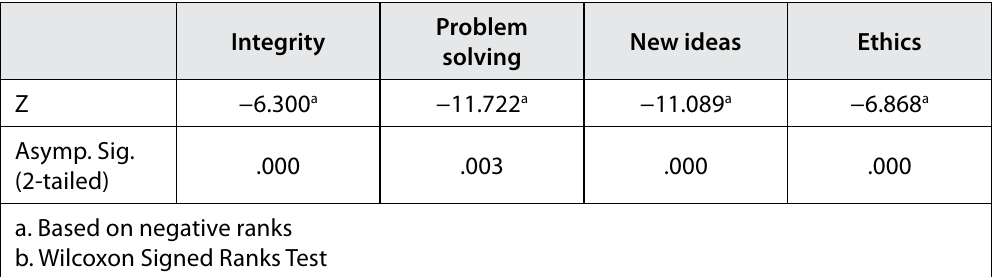
Table 8 Wilcoxon Test for employers and graduates concerning personal competency aspects of the